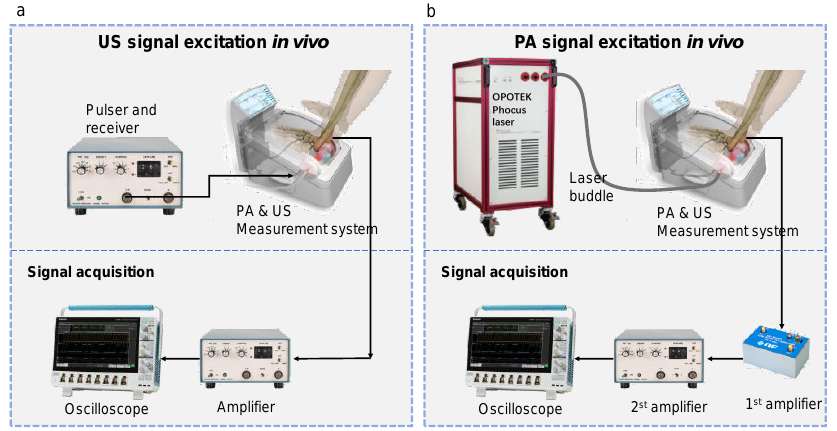
Figure 2. Experimental setup. ( a ) US and ( b ) PA measurement system for calcaneus bone in vivo.